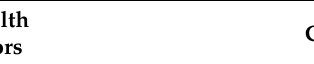
Table 2. Different tiers of soil health indicators